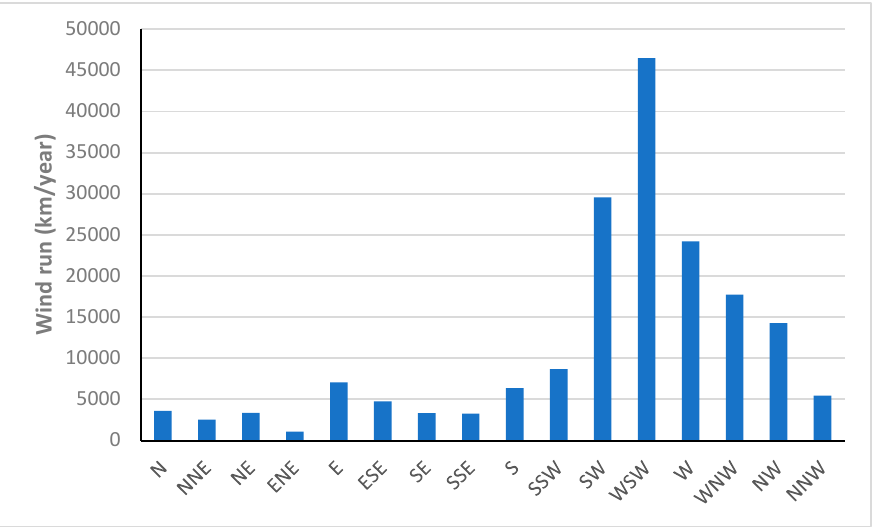
Figure 14. The annual wind run in different directions.